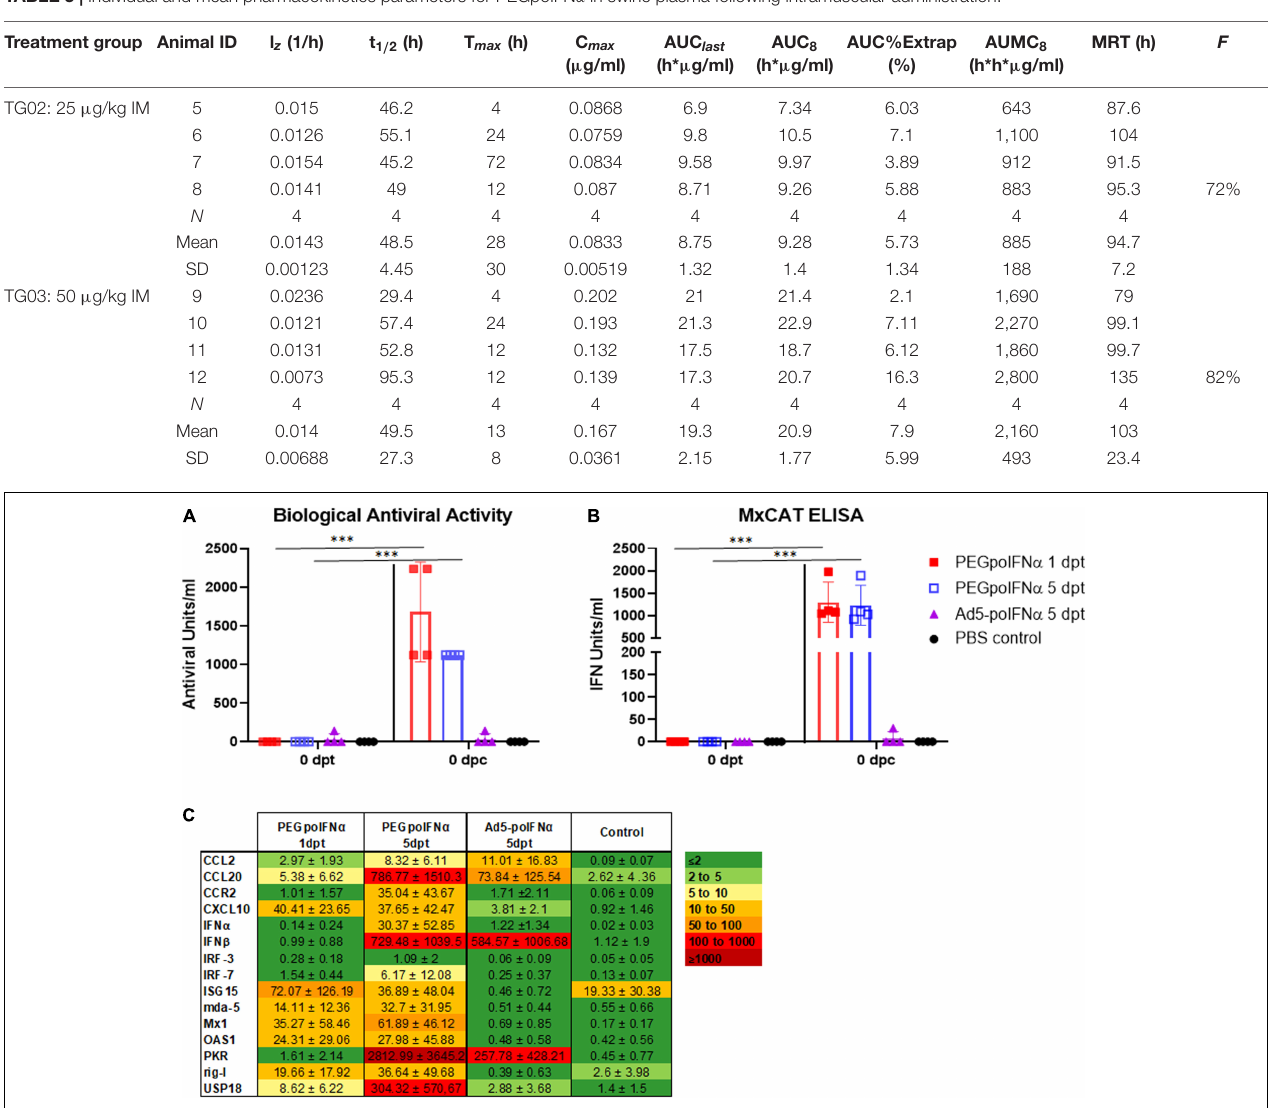
FIGURE 2 | Systemic antiviral response induced by treatment. Bioactivity against FMDV assayed by inhibition of virus growth (A) or by MxCAT ELISA (B) was determined in sera of treated animals with PEGpoIFN α or with Ad5-poIFN α after 1- or 5-days post-treatment (dpt) right before the animals were challenged (0 dpc). A group of PBS-treated animals was included as a negative control. For all groups, samples taken before any treatment (0 dpt) were used as baseline. Graph represents group average (bar) and individual values of each animal in the group at indicated time points. ∗∗∗ P ≤ 0.001. (C) Gene expression in PBMCs of treated animals with PEGpoIFN α or with Ad5-poIFN α after 1 or 5 dpt [right before the animals were challenged (0 dpc)] was measured by qRT-PCR. A group of PBS-treated animals was included as negative control. Results are expressed as relative fold induction values with respect to 0 dpt ( (cid:49)(cid:49) CT). GAPDH expression was used as